Question: Write a descriptive caption for this figure.
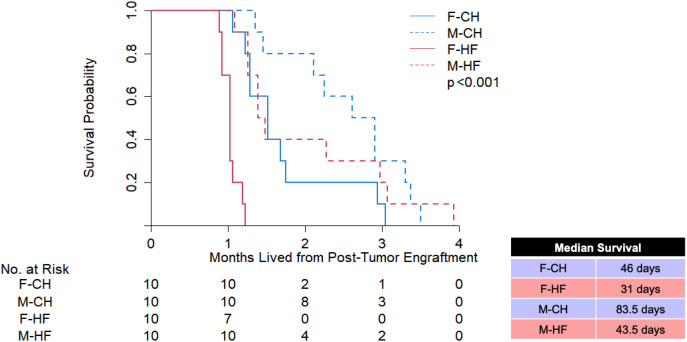
Answer: Effect of diet modulation on CLL survival. Kaplan-Meier survival analysis of all diets over the course of the study (F-CH, n = 10; F-HF, n = 10; M-CH, n = 10; M-HF, n = 10). P < 0.001. Calculated median survival time (days) is provided within the same figure panel. Multivariable Cox proportional hazards model comparing the effects of gender and diet on days-to-event is provided in Supplementary Table 2 . F-CH, female chow; F-HF, female high-fat; M-CH, male chow; M-HF, male high-fat.